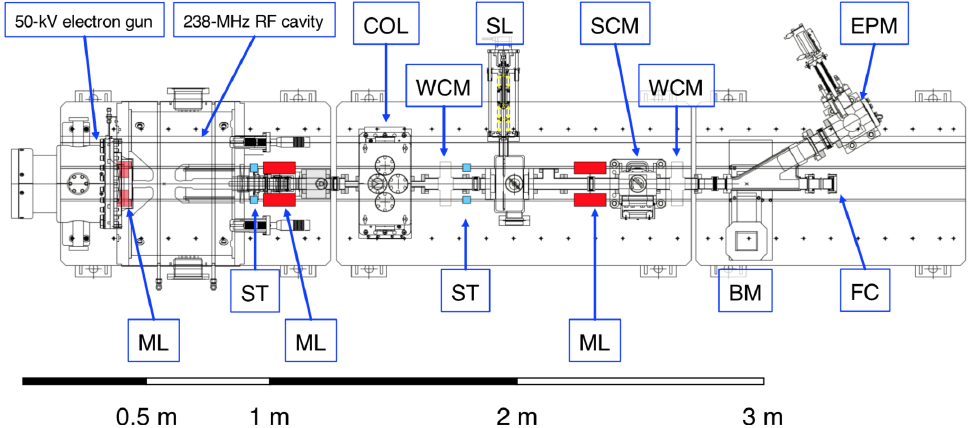
FIG. 8. Layout of the gun test stand. The symbols ML, ST, COL, SL, WCM, FC, SCM, EPM, and BM represent a magnetic lens, a steering coil, a beam collimator, a beam slit, a wall current monitor, a Faraday cup, a screen monitor, an energy profile monitor, and a 30° bending magnet, respectively.